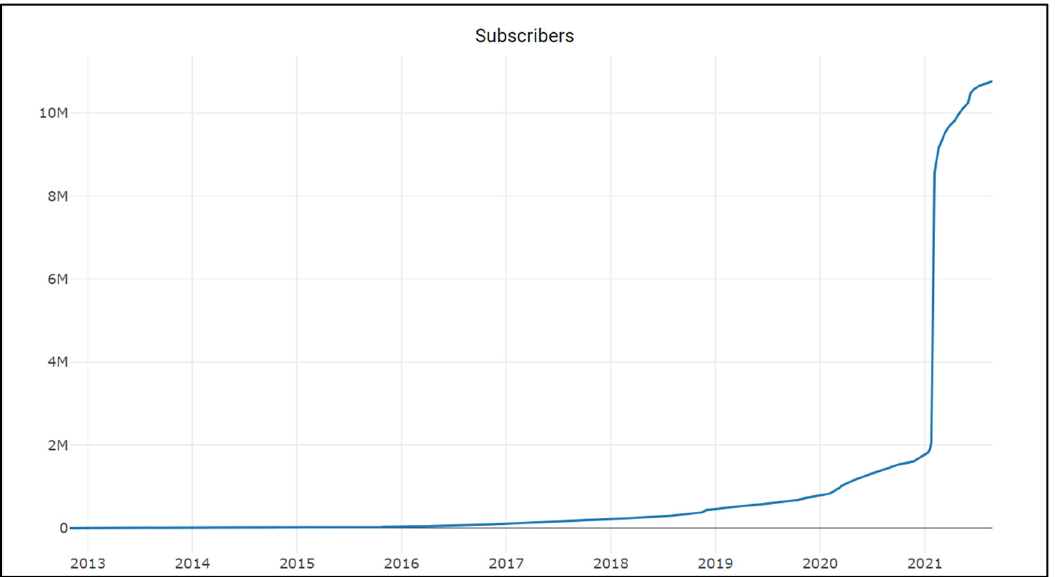
Figure 2. Number of r/WallStreetBets members since its inception in 2012.